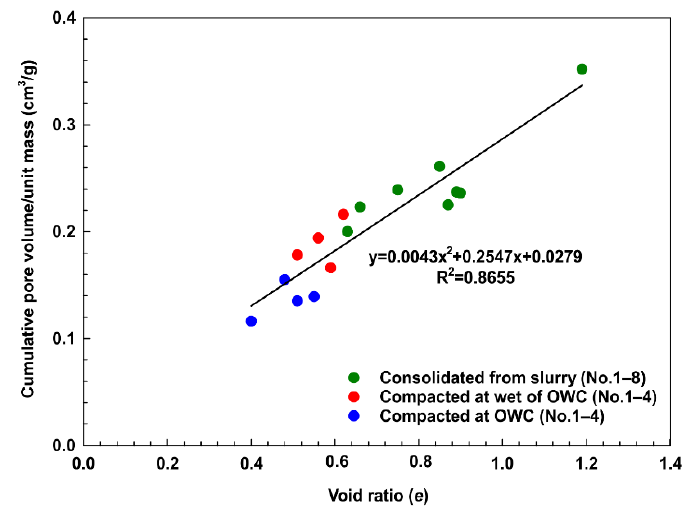
Figure 16. Cumulative pore volume-void ratio relationship for all samples.